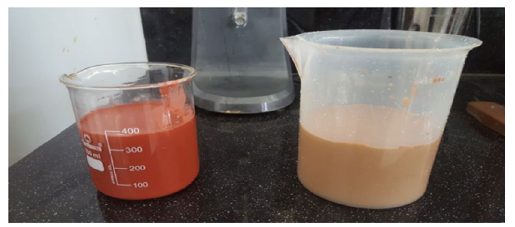
tonite mud (right)